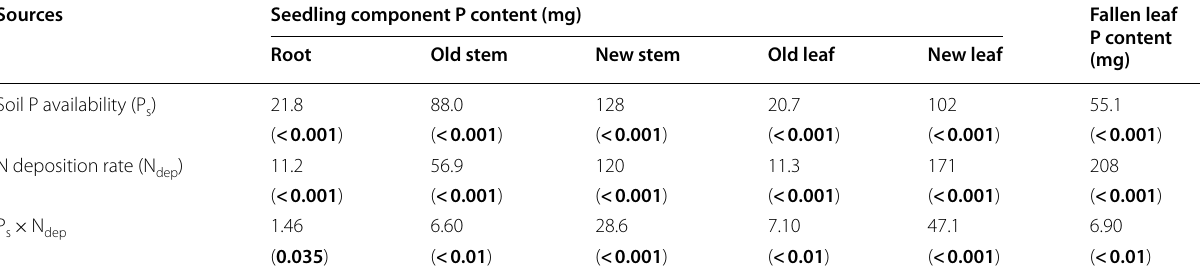
Table 3 Effects of soil P availability (P P. edulis seedlings and the fallen leaves ( n ( P < 0.05) are highlighted in bold text